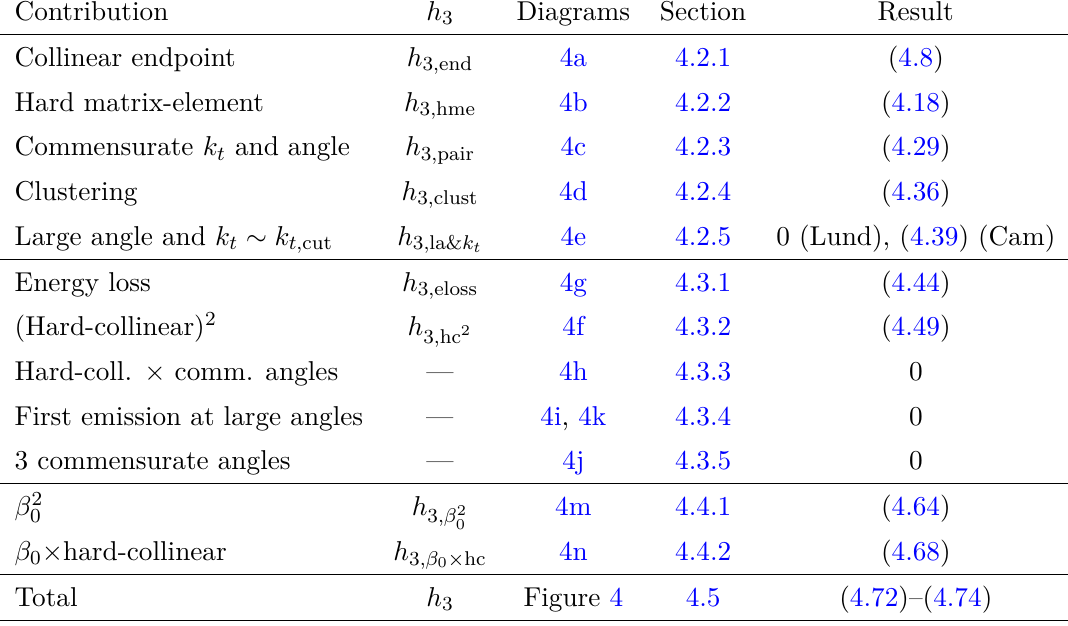
Table 1. Relevant coefficients for the NNDL function h 3